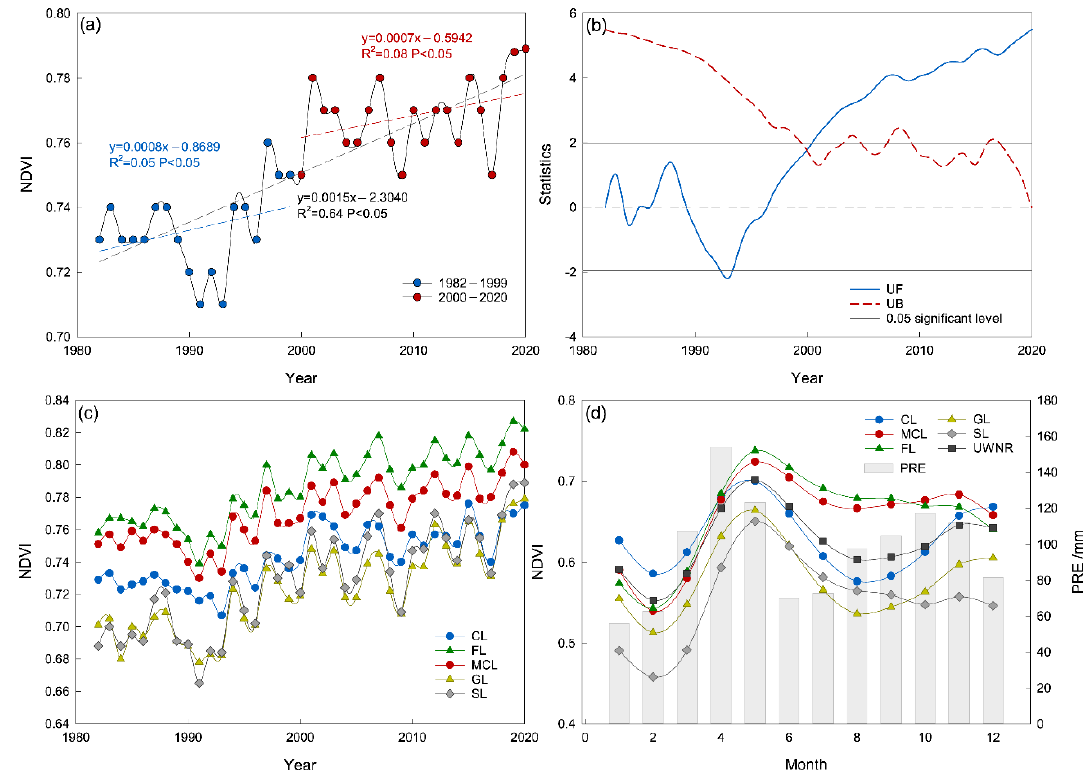
Figure 4. Changes of the NDVI in the UWNR from 1982 to 2020. ( a ) Piecewise linear fitting of the inter annual variation in the NDVI. ( b ) Mann-Kendall mutation test of the NDVI in the UWNR. ( c ) Interannual variations in the NDVI in different vegetation types from 1982 to 2020. ( d ) Monthly variation in the NDVI (1982–2020) and PRE (1982–2018) in the UWNR.